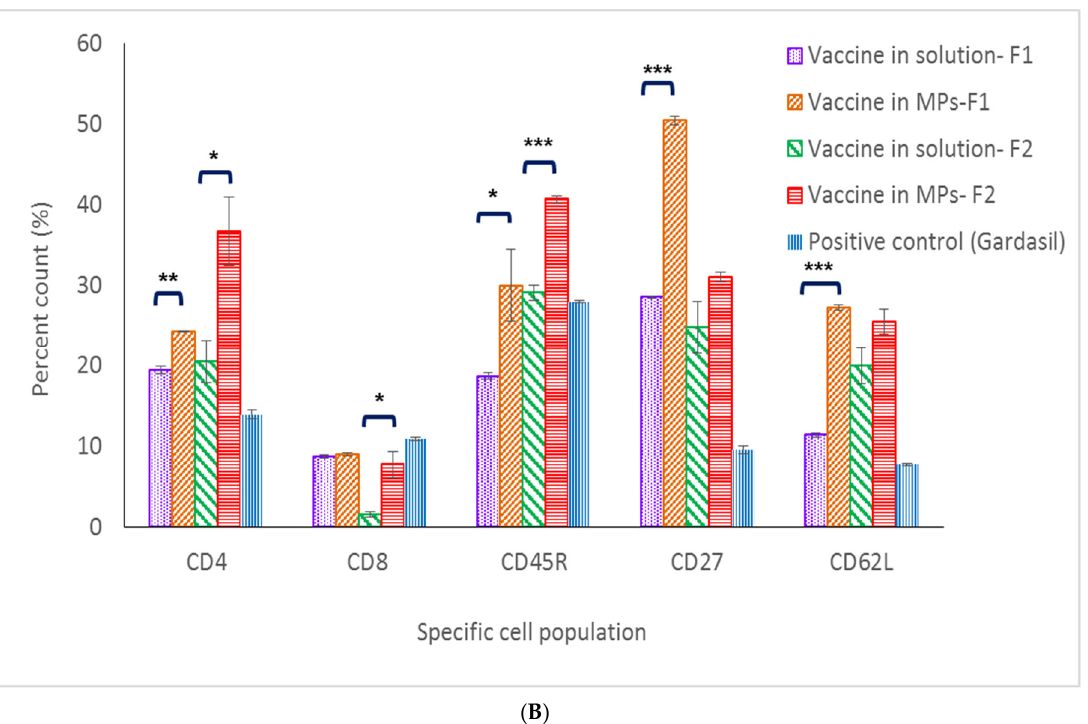
Figure 6. Percent cell count of lymphocyte populations in lymph node ( A ) and the spleen ( B ). (* p < 0.5, ** p < 0.01, *** p < 0.001).